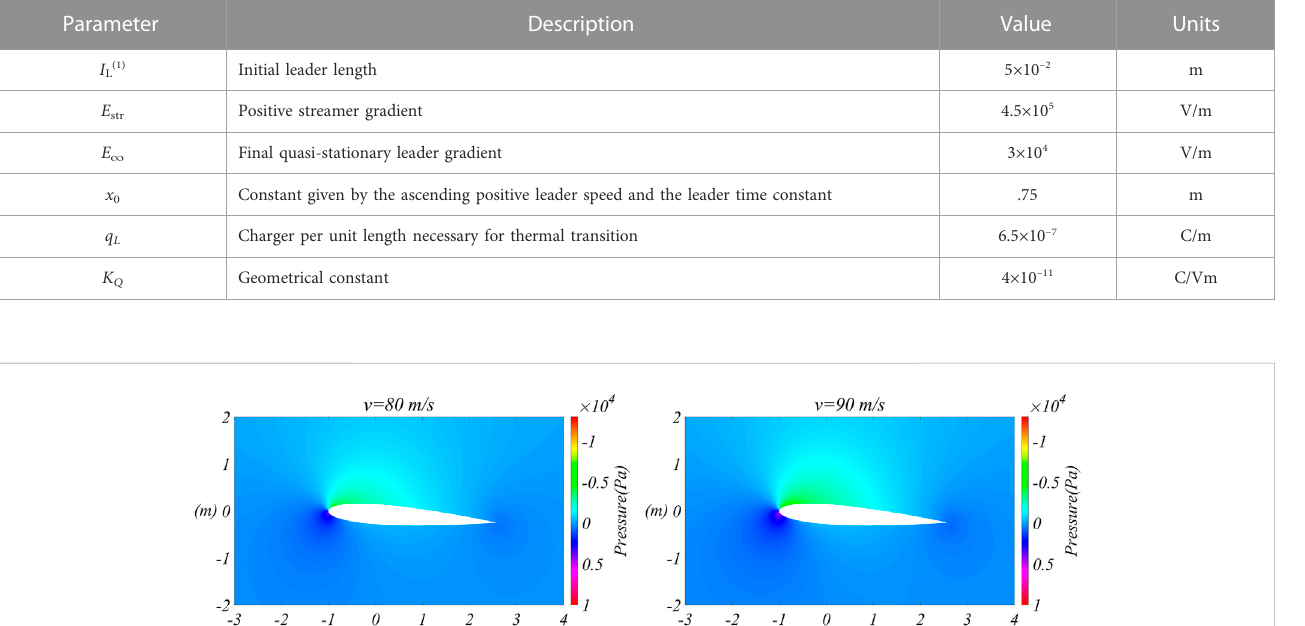
TABLE 1 The parameters.